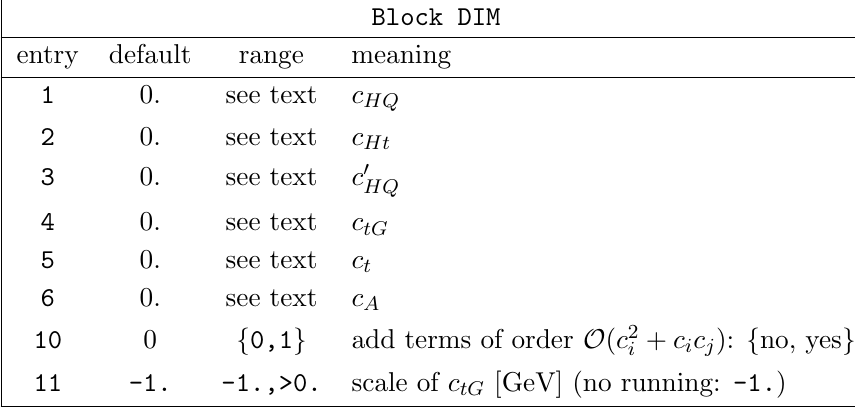
Table 20 . Coe(cid:14)cients of dimension-6 operators are speci(cid:12)ed in Block DIM